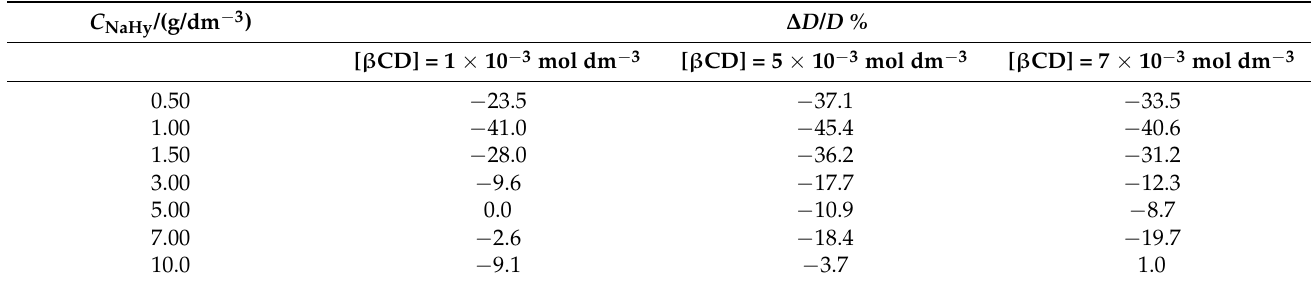
Table 2. Tracer diffusion coefficients ( D 11 , D 12 , D 21 , D 22 ) for NaHy (component 1) in aqueous β